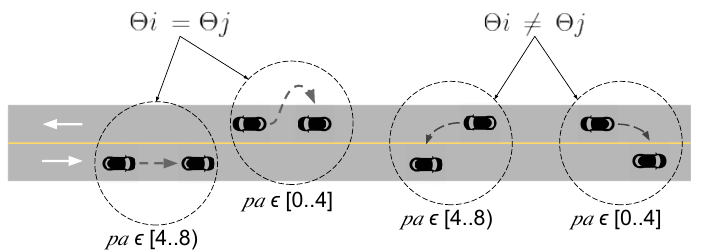
Figure 5. Pseudo-angle analysis for the highway